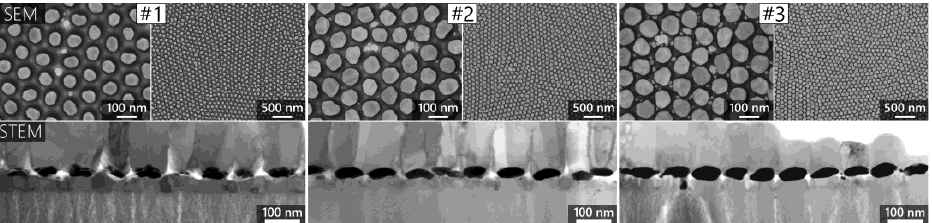
Figure 4. Top : SEM images of three different AuNP arrangements (type #1, #2, and #3) over the aluminum template (Figure 1: 6). Bottom : STEM (BF) images of the same AuNP arrangements as a final sensor element on SiO 2 nanopillars/substrate (Figure 1: 9b). In STEM images the aluminum layer (~300 nm) can be seen covering AuNPs and partly filling gaps between SiO 2 pillars. The Al layer was used to prepare lamellae of ~100 nm thickness.